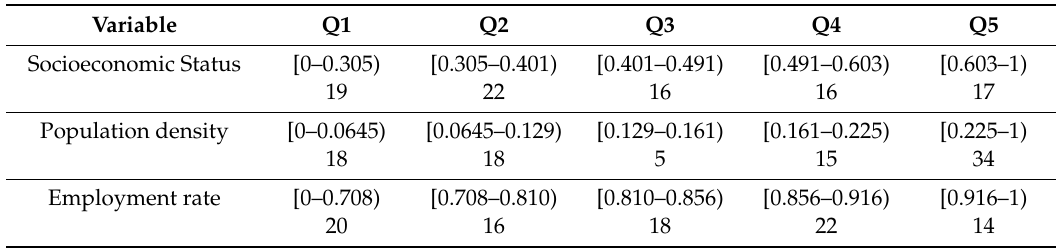
Figure 6. Location of selected NPAs. Table 1. Quintile ranges for each of the nine variables used in the optimization process and number of sample points within each